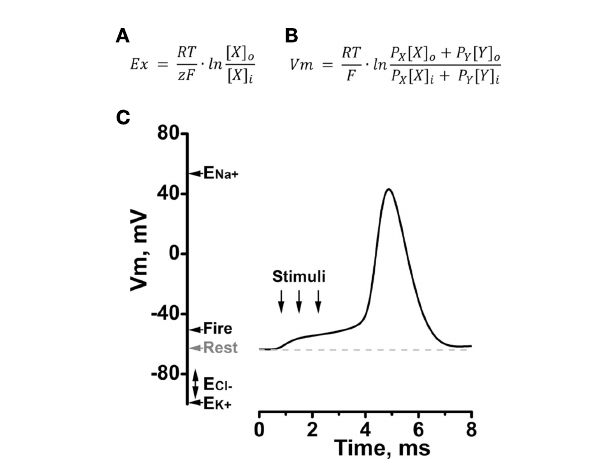
FIGURE 1 |The neuronal membrane potential during rest and excitation. Cellular membrane potential ( V m ) is determined by the internal and external ionic compositions and the relative permeability of the membrane to each ion species. Under quasi-physiological conditions, resting V m for a neuron falls between ∼ − 60 and − 75mV and is determined in large part by the magnitude of the K + leak current. (A) The Nernst equilibrium potential for cation X ( E x ) is calculated using the Nernst equation, where R is the Gas constant (1.987calK − 1 mol − 1 ), T is the temperature in Kelvin, z is the charge of the ion and F is Faraday’s constant (9.648 × 10 4 Cmol − 1 ) and [ X ] o and [ X ] i are the external and internal concentrations of X , respectively. (B) The Goldman–Hodgkin–Katz equation shows that V m is determined by the relative concentrations and permeabilities ( P ) of cations X and Y . (C) An exemplar action potential evoked in a neuron by depolarizing stimuli.Values for V m corresponding to rest, the firing threshold for the action potential (Fire) and the Nernst potentials for Na + ( E Na ), K + ( E K ), and Cl − ( E Cl ) are